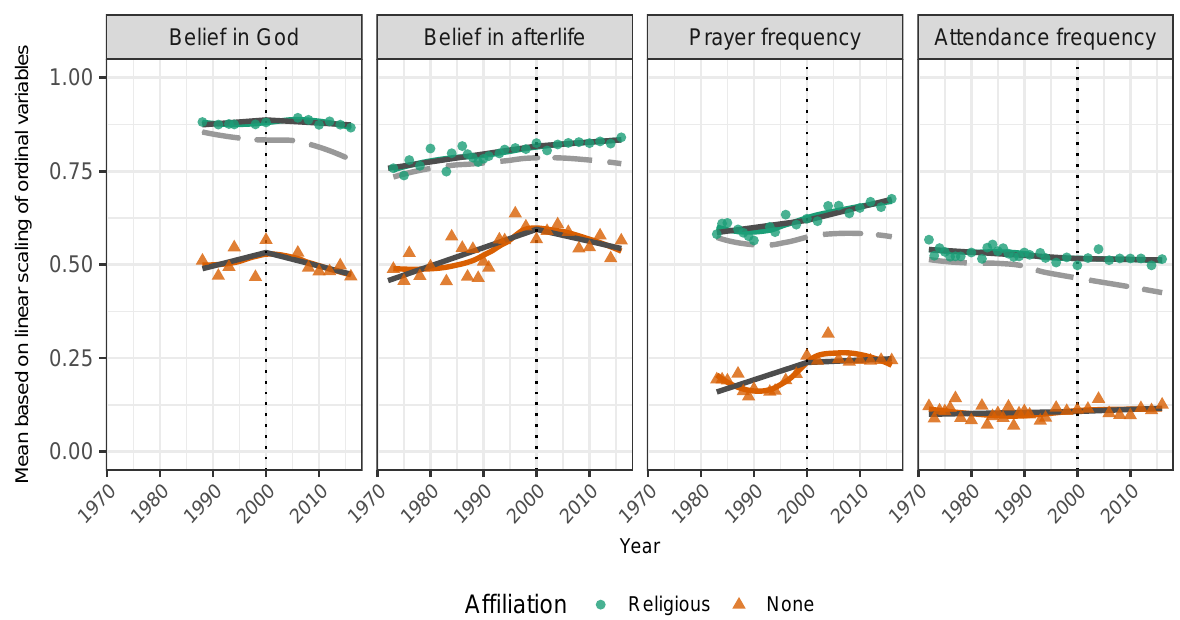
Figure 2: Trends in religious beliefs and practices among the religiously affiliated and unaffiliated from General Social Survey sample data. All ordinal questions are converted to a linear quantitative scale with a maximum of one and a minimum of zero. All means are sample weighted. Smoothed trend lines are shown for each group, and a smoothed trend for all respondents is shown by the light grey, dashed line. The fit of a regression spline model with a hinge at year 2000 is shown in dark